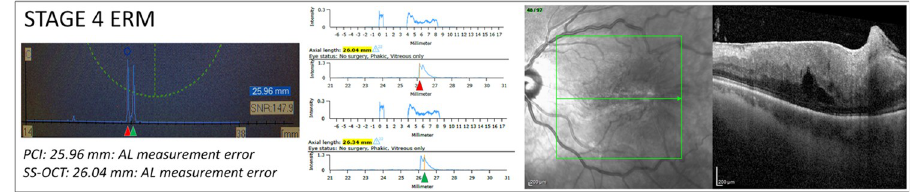
Fig 3. AL measurement error of the PCI and SS-OCT devices in a case of ERM stage 4. Left part: PCI biometric output in a case of ERM stage 4, as shown in the OCT B-scan on the right. The measured mean AL is 25.96 mm. Middle part: SS-OCT biometric output of the same eye with two different measurements. Top: the mean AL, measured by moving the cursor on the first peak, is 26.04 (highlighted in yellow); bottom: the mean AL, measured by moving the cursor on the second peak, is 26.34 (highlighted in yellow). The first peak presents greater signal intensity compared to the second. AL measurements from both devices were considered erroneous. In the PCI biometric output, a double peak is present with two distinct peaks presenting similar signal intensity. In the SS-OCT biometric output a significant double peak is visible. The first peaks (red arrowheads) likely correspond to the vitreoretinal interface. The second peaks (green arrowheads) may correspond to the RPE or outer retinal